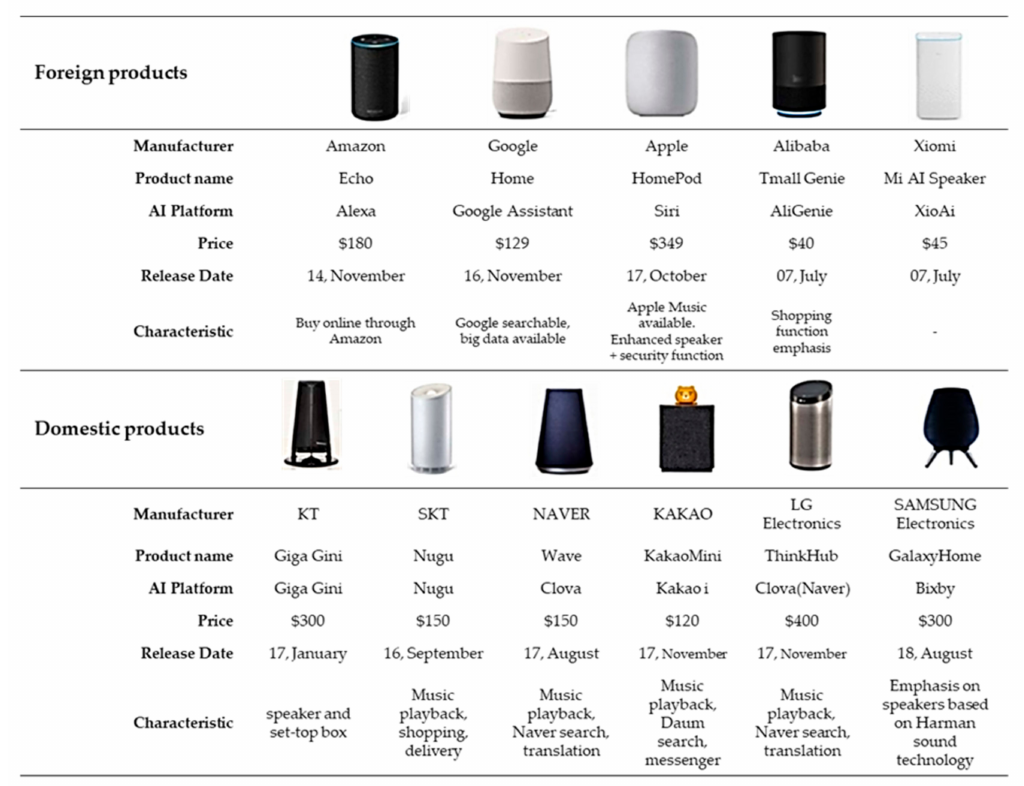
Figure 1. Types of domestic and foreign AI speakers